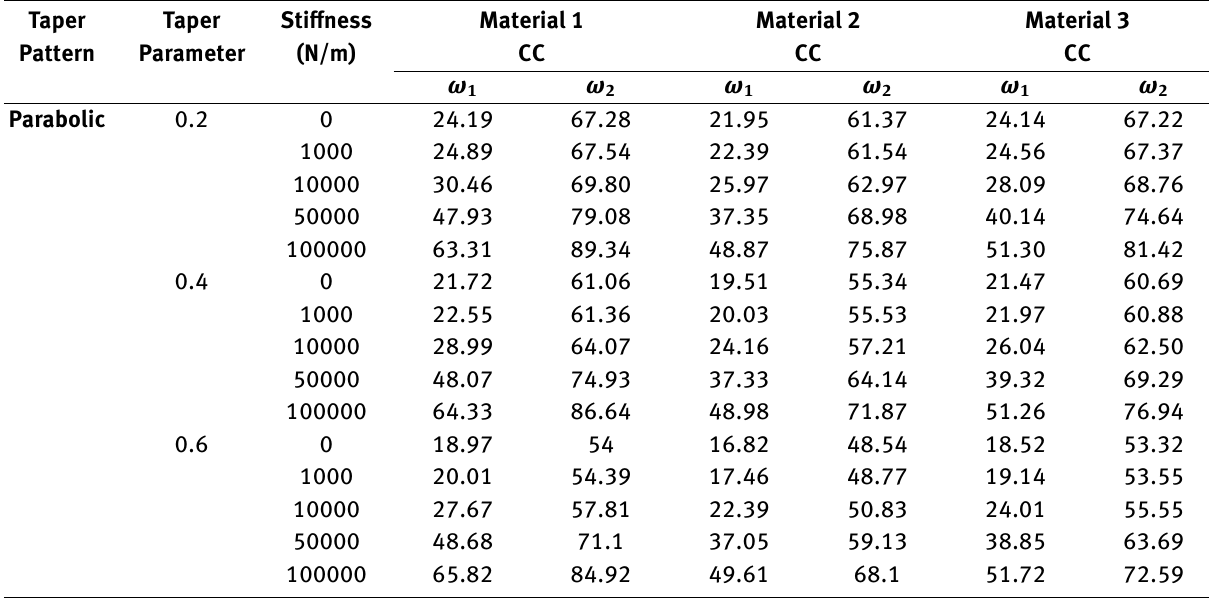
Table 4: Values of natural frequencies for 1 st and 2 nd mode ( ω 1 and ω 2 ) corresponding to parabolic tapered clamped AFG beam for different combinations of taper parameter, spring stiffness and material